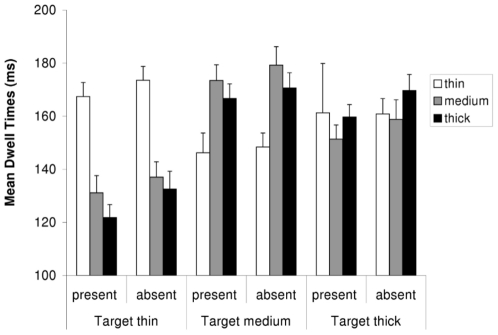
Results: Mean Dwell Times of Fixations on Each Distractor.The mean dwell times on each distractor type, depicted separately for the thin, medium and thick search target. Error bars depict +1 SEM.